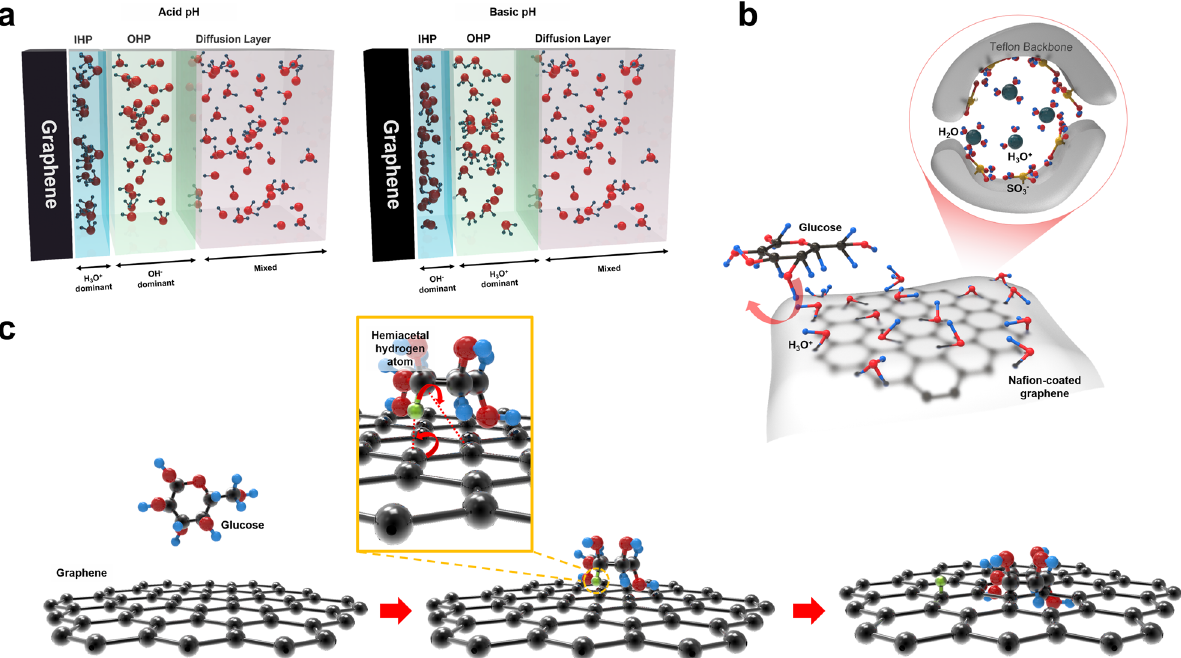
Fig. 8 Schemes illustrating the sensing mechanism of target materials for each type of SFET. a Sensing mechanism of H 3 O + (acidic pH), OH − (basic pH) for graphene. b Sensing mechanism of Na fi on-coated graphene selectively detecting H 3 O + . c Sensing mechanism of graphene detecting